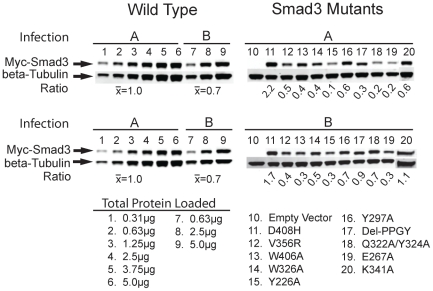
Comparable expression levels of wild-type myc-Smad3 and myc-Smad3 variants in infected C2C12 cell populations.Cell lysates were prepared from two independent sets (A and B) of C2C12 cell populations independently infected with retrovirus encoding wild-type myc-Smad3 (blots on the left) and either mutant myc-Smad3 genes or retrovirus without the myc-Smad3 gene (Empty Vector, EV, blots on the right). The lysate proteins were resolved by SDS-PAGE. Western blots were probed with anti-myc antibody and IRDye goat anti-mouse 800 secondary antibody, as well as anti-beta-Tubulin antibody and IRDye goat anti-rabbit 680 secondary antibody and imaged on an Odyssey IR scanner. Titrations of wild-type Smad3 lysates from both infections were analyzed two times (left-top and left-bottom of figure) and were used to generate a standard curve. Total lysate protein (2.5 µg) was loaded for lysates from cells infected with EV or mutant Smad3 retroviruses with the exception of K341A (1.25 µg, lane 20, infection B). The lack of signal in the EV cell lysates loaded in lane 10 of each gel indicates that the signal being detected is myc-Smad3. The ratio represents the expression of myc-Smad3 relative to the beta-Tubulin loading control. The “Infection A” set had expression of mutant Smad3's within a ten-fold range of wild-type myc-Smad3; the “infection B” set had expression of mutant Smad3's within a three-fold range of wild-type myc-Smad3. The Smad3 D408H mutation (lane 11) consistently had the highest levels of Smad3 protein expression.